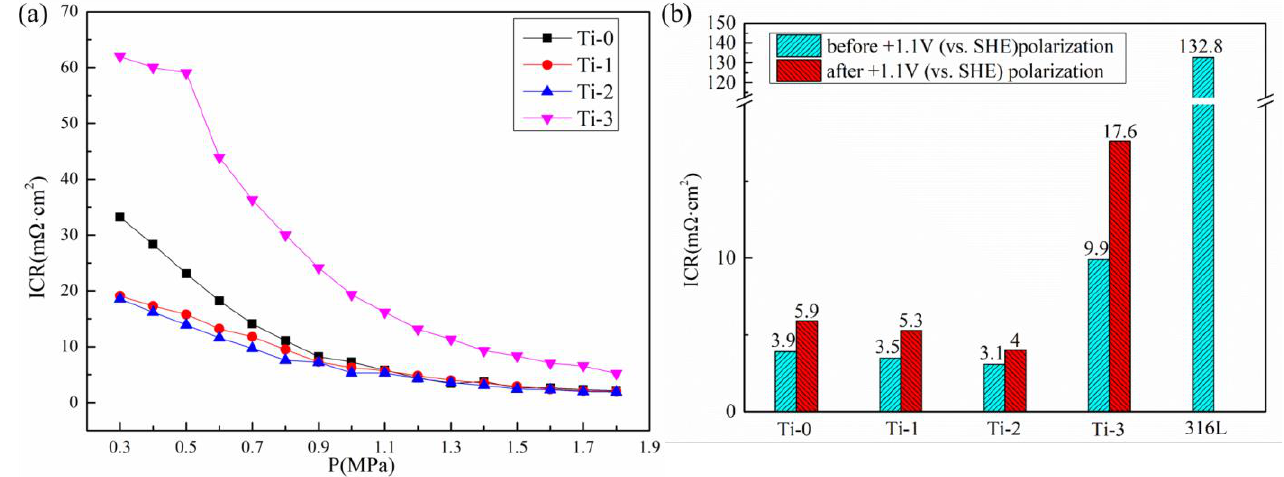
Figure 8. The ICR values of bare 316L stainless steel and coated samples. ( a ) Contact resistance under different pressures, ( b ) ICR values at 1.4 MPa.